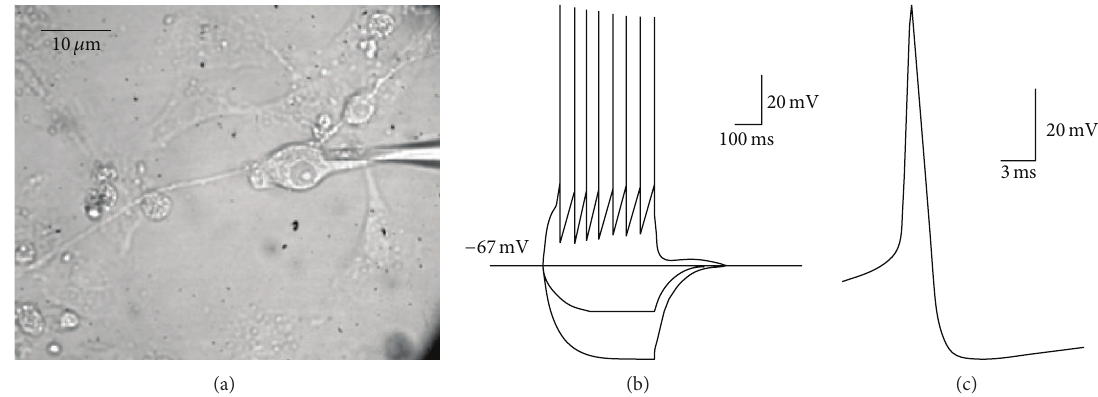
Figure 8: Whole-cell current-clamp recordings of differentiated chicken neurons generated from iPSC-like cells reveal action potential firing. (a)DICimageshowingasinglecell(arrow)withrecordingpipetteinwhole-cellconfiguration(arrowhead).(b)Membranepotentialresponses generated by current injection. Suprathreshold depolarizing currents resulted in trains of overshooting action potentials. (c) Expanded view of a single action potential illustrating narrow spike width and strength after